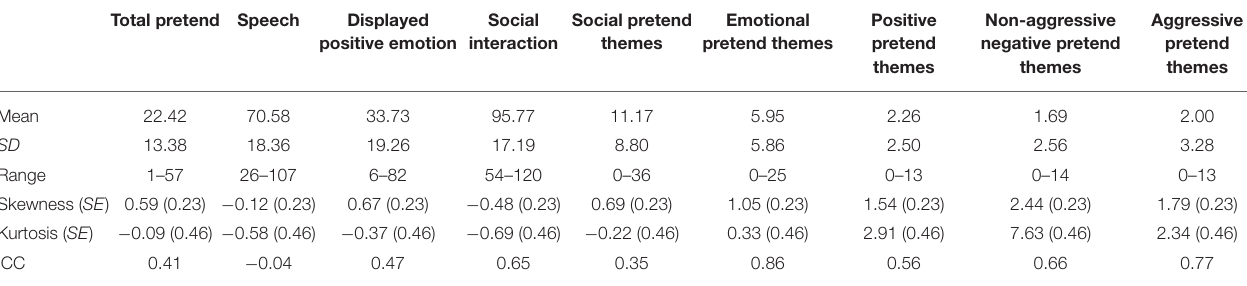
TABLE 1 | Descriptive statistics and intra-class correlations (ICC) for play observation variables ( N = 108).